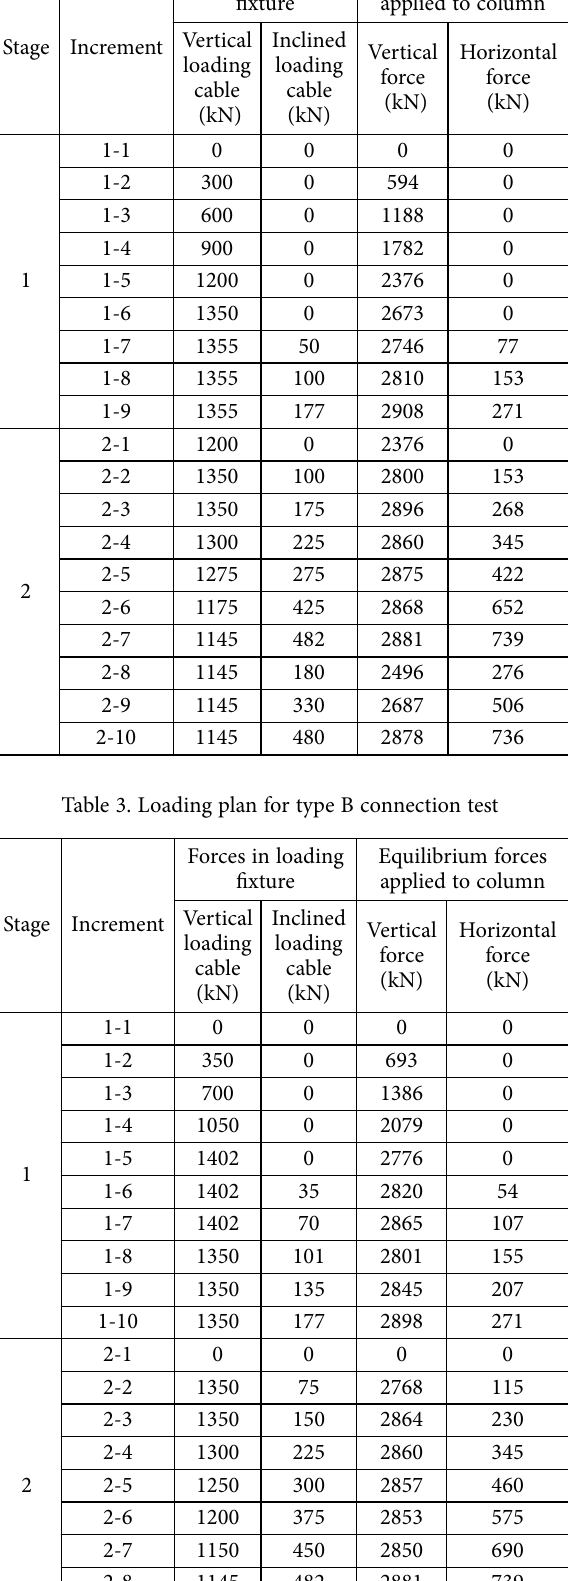
Stage Increment